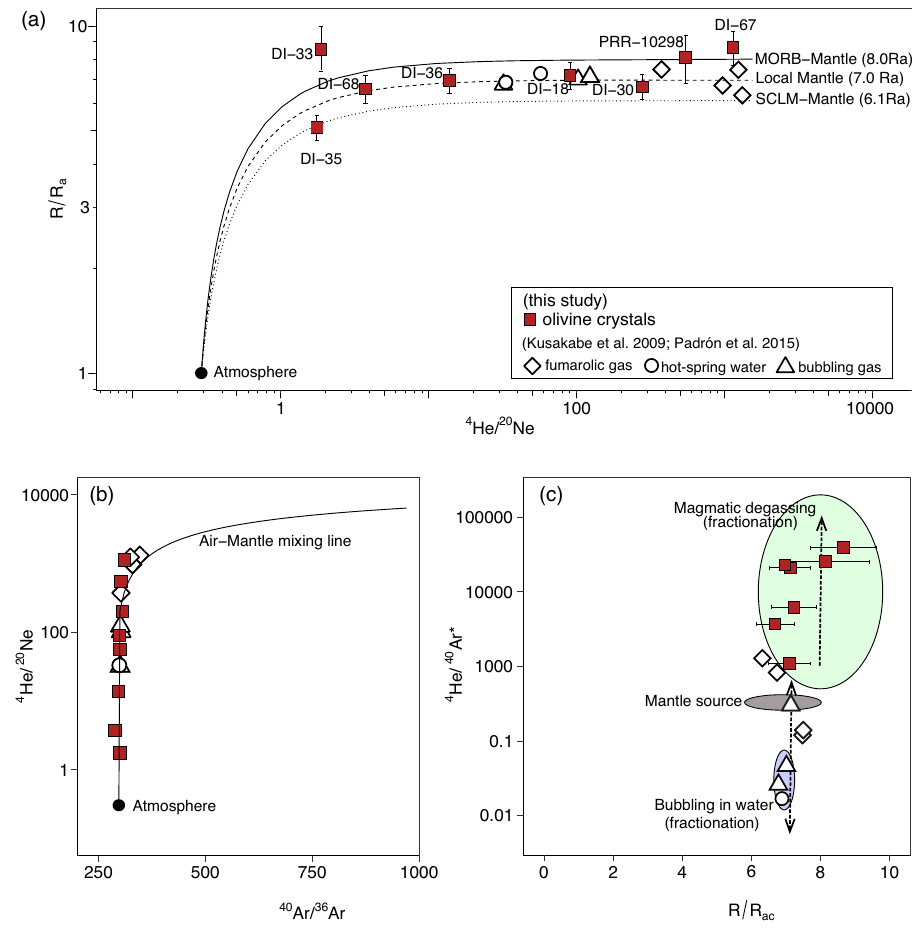
Figure 2. ( a ) 3 He/ 4 He versus 4 He/ 20 Ne diagram for Deception Island samples, showing mixing curves between low and high 4 He/ 20 Ne values of atmospheric, MORB and SCLM components (e.g., 57 ); ( b ) samples with the lowest 4 He/ 20 Ne values also have lowest 40 Ar/ 36 Ar values indicative of air contamination (see text and Table 1 for more details); ( c ) 4 He/ 40 Ar * versus 3 He/ 4 He highlighting the mantle source area and the two main fractionation fields, i.e., magmatic degassing and bubbling in the waters (dashed arrows). Fumaroles and hot spring samples shift from the mantle source value (2–5) to (i) higher values due to magma degassing (as the olivines), and (ii) to lower values by fractionation during degassing from magma or dissolving in water followed by bubbling. Note that the noble gas isotopic ratios from the olivine crystals are plotted together with those from fumaroles and hot spring waters, which already represent fractionated noble gas elemental